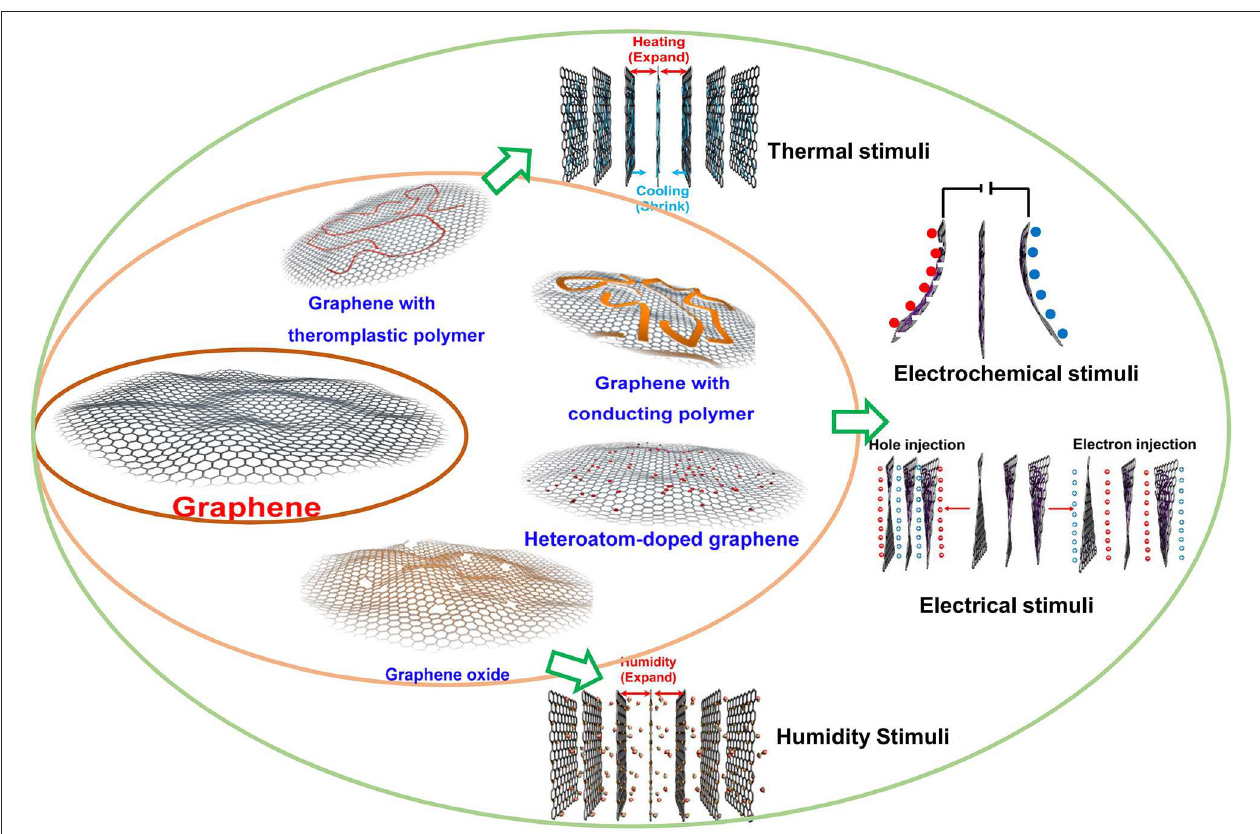
FIGURE 1 | Schematic illustration of strategies toward tunable-deformed graphene materials.